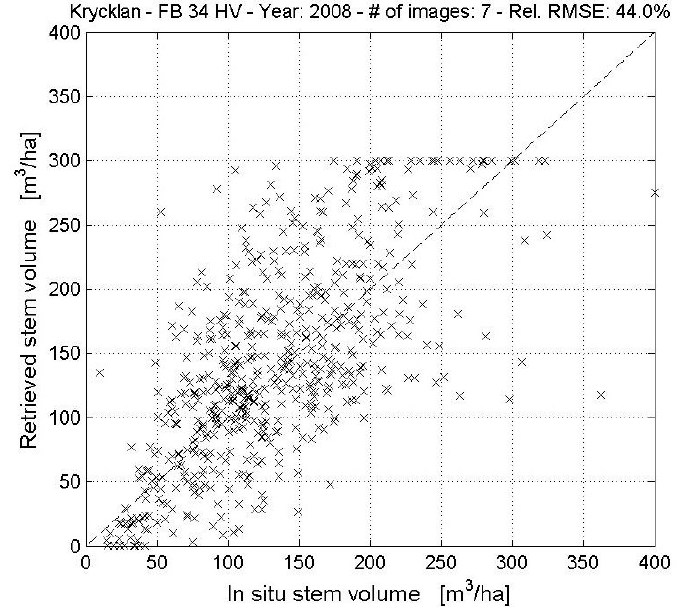
Figure 11. Scatter plot of retrieved stem volume with respect to in situ stem volume in the case of all HV-polarized images acquired during 2008 over Krycklan with a look angle of 34.3°.